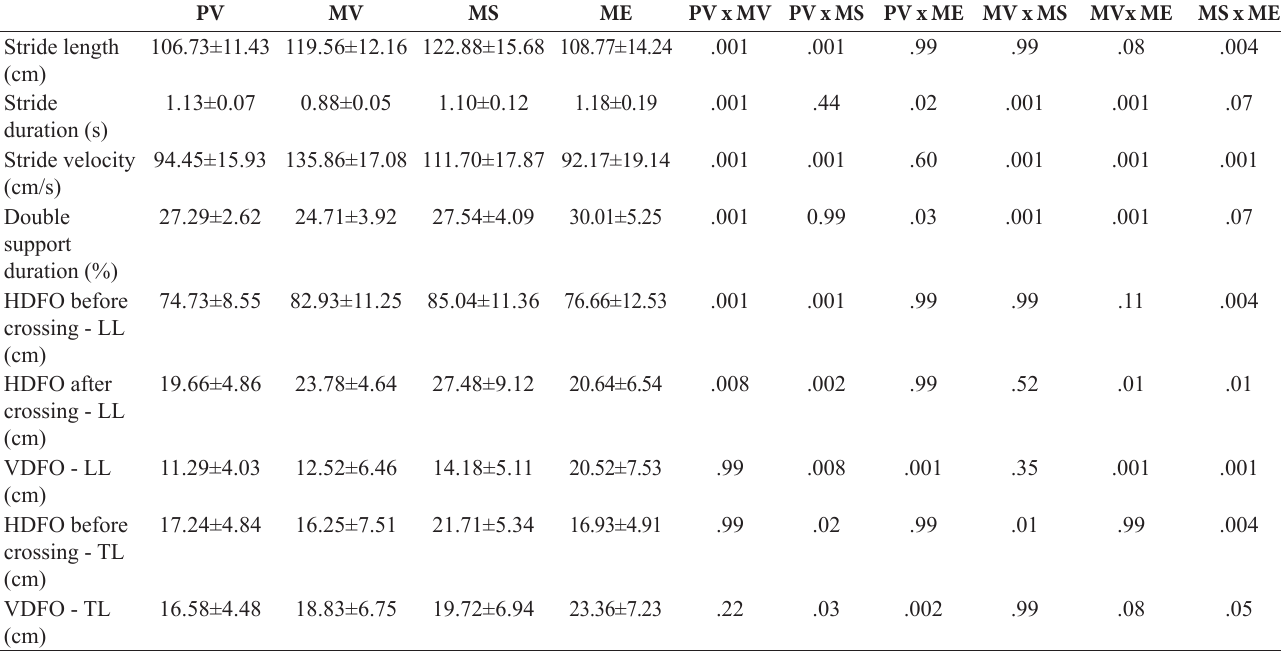
Table 2. Means and standard deviations of spatial-temporal parameters for each experimental condition. HDFO: horizontal distance from the foot to the obstacle; VDFO: vertical distance from the foot to the obstacle; LL: leading limb; TL: trailing limb. PV: Preferred velocity to cross the obstacle; MV: Maximum velocity to cross the obstacle; MS: Maximum step length to cross the obstacle; ME: Maximum elevation of the feet to cross the